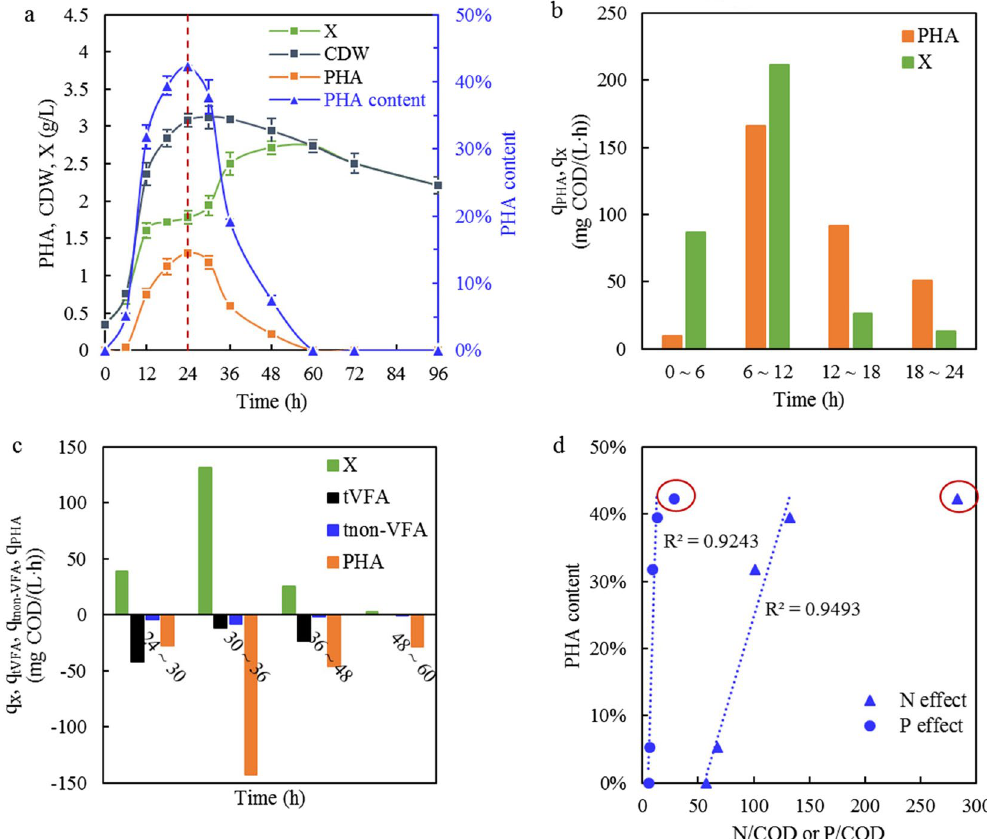
Figure 2. Profiles of PHA and biomass concentration during one cycle ( a ), the specific production rates in feast phase ( b ), the degradation and utilization rates in famine phase (negative values) ( c ), and the effects of nutrients on PHA content ( d ) in the SBR operated under stability. Red dashed lines mark the end of feast phase. Red circles mark the outliers away from the trend lines. Figure d only shows the data in feast phase. (bars = S.D., n =